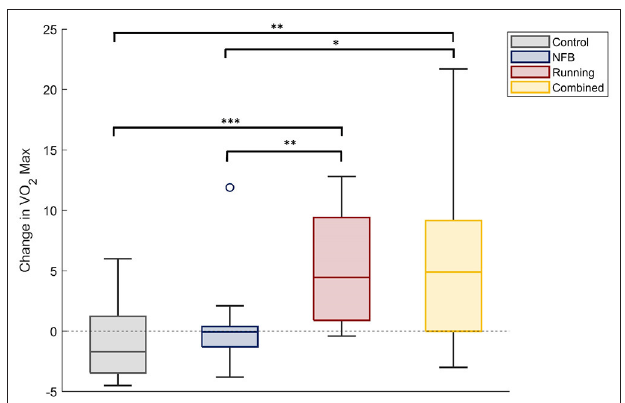
FIGURE 2 | The change in VO2-max scores of participants within each experimental group. The Running and Combined groups show a significant increase in VO2Max compared to the Control and NFB groups. Significance of post-hoc pairwise independent samples t -tests are represented by * p < 0.05, ** p < 0.01, and *** p <